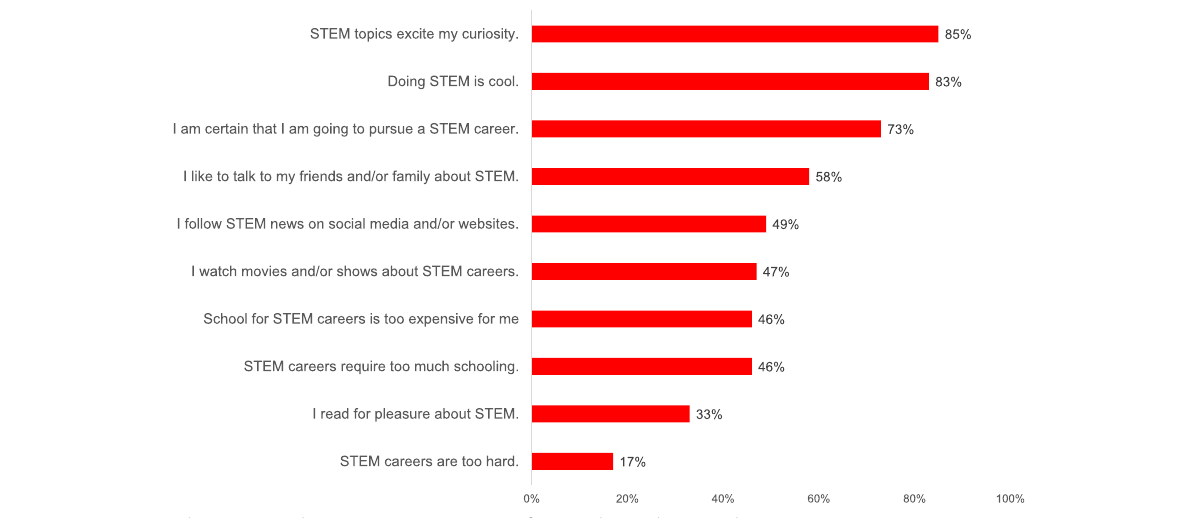
Fig. 4 Agreement with STEM attitude statements (percentage of respondents who strongly